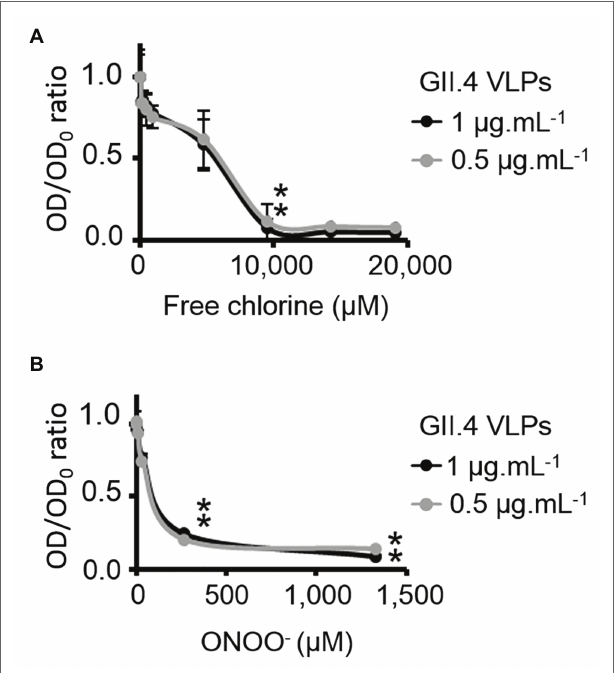
FIGURE 3 | Free chlorine and ONOO − prevent HBGA-binding to GII.4 VLPs. Assays of HBGA-binding to GII.4 VLPs using ALe + saliva following free chlorine (A) and ONOO − (B) treatments were presented. The OD/OD 0 ratio values were determined by dividing the mean OD 450 values obtained by HBGA-binding ELISA at each oxidant concentration (OD) by the mean OD 450 values obtained in the untreated control (OD 0 ). Two concentrations of GII.4 VLPs were tested: 1 μ g.ml −1 (black circles and line) and 0.5 μ g.ml −1 (gray circles and line). Each data point corresponds to the mean OD 450 values emanating from three independent experiments with duplicate measures carried out on different days (except for VLPs treated with free chlorine at final concentrations of 14,297 and 19,062 μ M, for which one replication was performed). Error bars indicate standard deviations. *Unpaired Student’s t -test was used to compare groups with p <